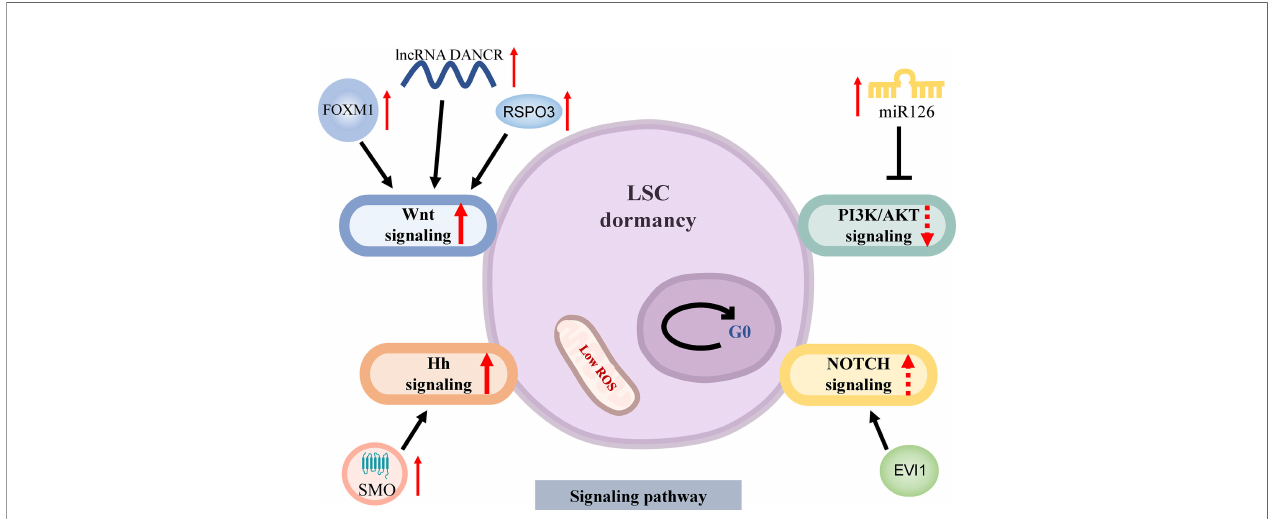
FIGURE 2 | Signaling pathways of dormancy in LSCs. LSCs arrest the cell cycle at G0 phase in a low level of ROS. The Wnt signaling pathway is activated through overexpression of FOXM1 which stabilizes b -catenin, up-regulated RSPO3 by activating b -catenin and increased lncRNA DANCR which upregulates MYC expression to induce LSCs dormancy. The repression of PI3K/AKT signaling pathway by miR126 mediates the stemness of LSCs and drug resistance. The abnormal activation of the Hh and NOTCH signaling pathways plays an important role in maintaining LSCs quiescence. AML, acute myeloid leukemia; LSCs, AML stem cells; ROS, reactive oxygen species; Hh, Hedgehog; SMO, smoothened; EVI1, Ecotropic virus integration site